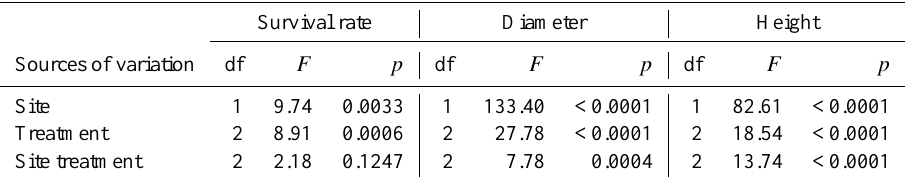
Table 2. Summary of the results of the two-way ANOVA investigating the effects of site and treatment on the survival and growth of J. curcas seedlings Survival rate Diameter Height